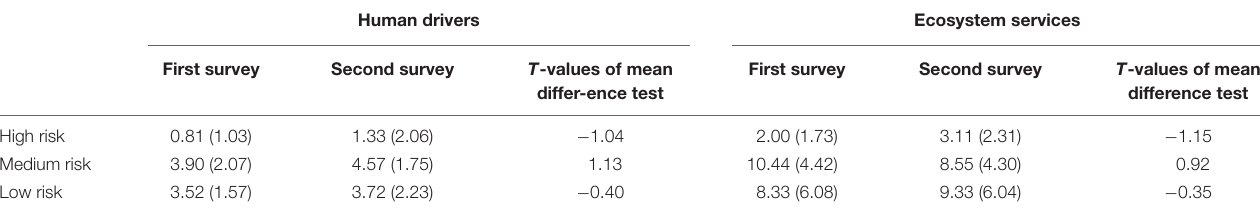
TABLE 3 | Mean number of human drivers posing high, medium and low risk to ecosystem services, and mean number of ecosystem services at high, medium and low risk from human drivers, in the first and second